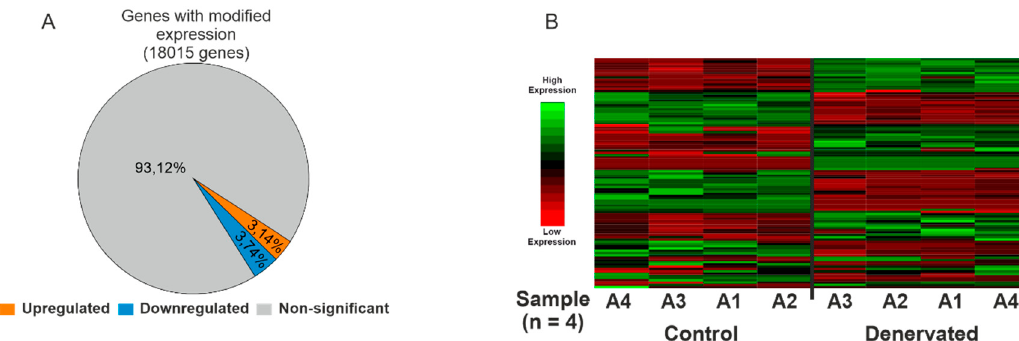
Figure 2. Differential RNA-seq analysis of denervated skeletal muscle compared to control, innervated muscle. ( A ) Pie Chart shows the percentage of genes with no significant expression changes (grey), significantly upregulated (orange) and significantly downregulated (blue). ( B ) Heatmap showing the 50 top upregulated and downregulated genes upon denervation. Each row represents the expression level of a particular gene in control ( n = 4) and denervated samples ( n = 4).